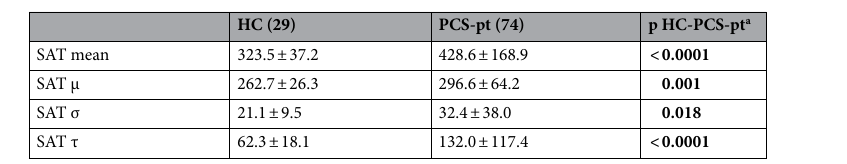
Table 4. Mann Whitney analysis for comparing parameters of Sustained Attention Task (SAT) RTs. Significant values are in [bold]. a All comparisons remained significant after the Benjamini–Hochberg adjustment.